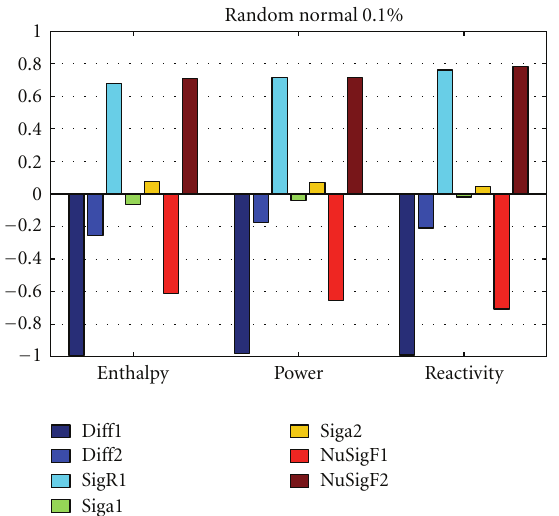
Figure 8: Partial rank correlation coe ffi cient for LHS normal 0.1%, output variable:Power.